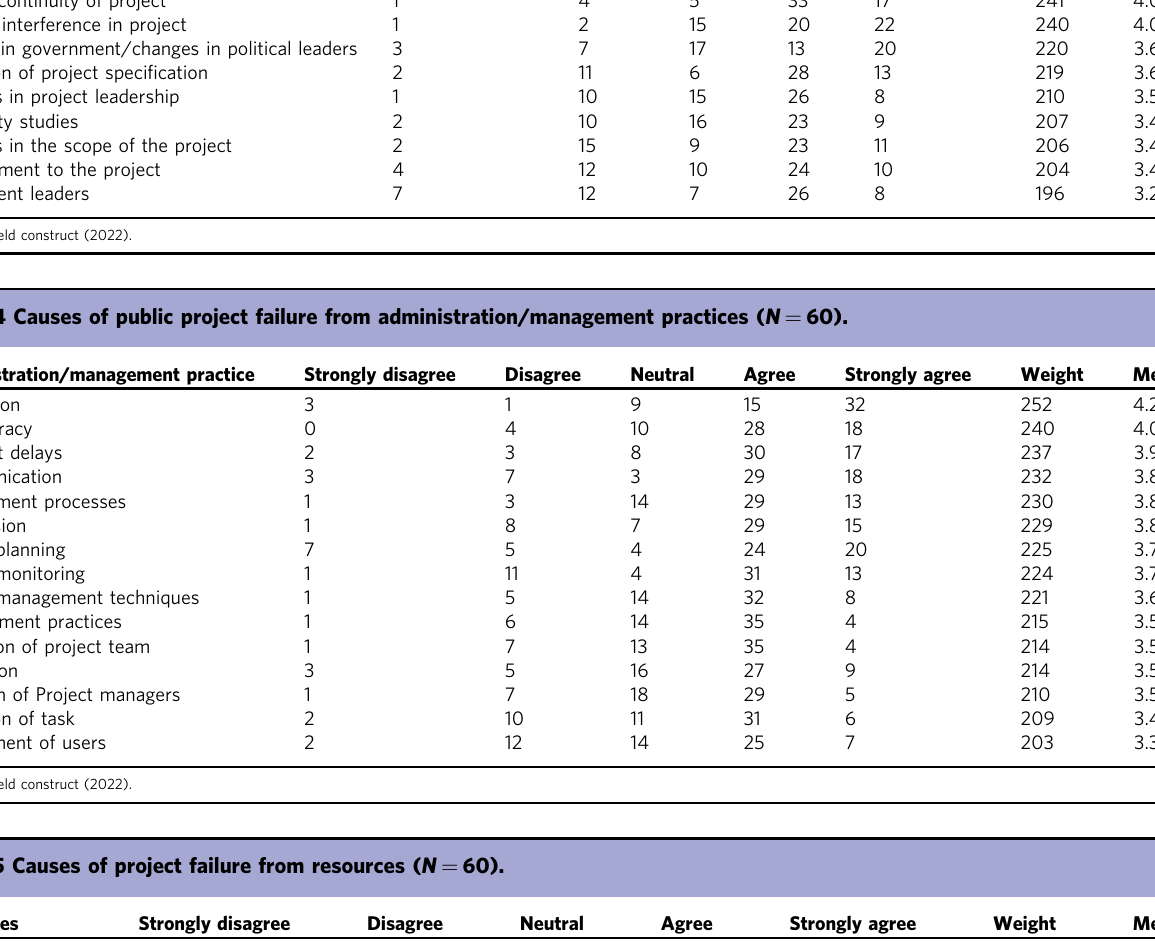
Table 5 Causes of project failure from resources ( N = 60). Resources